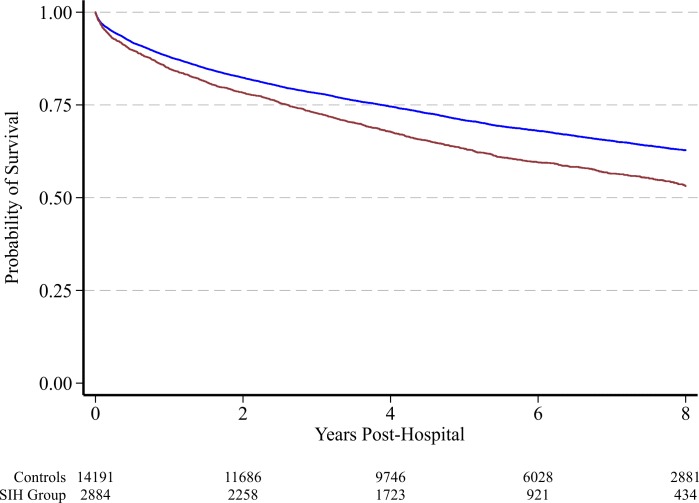
Kaplan-Meier survival curves for the control group (blue line) and stress induced hyperglycemia (red line) from hospital discharge to 8 years.